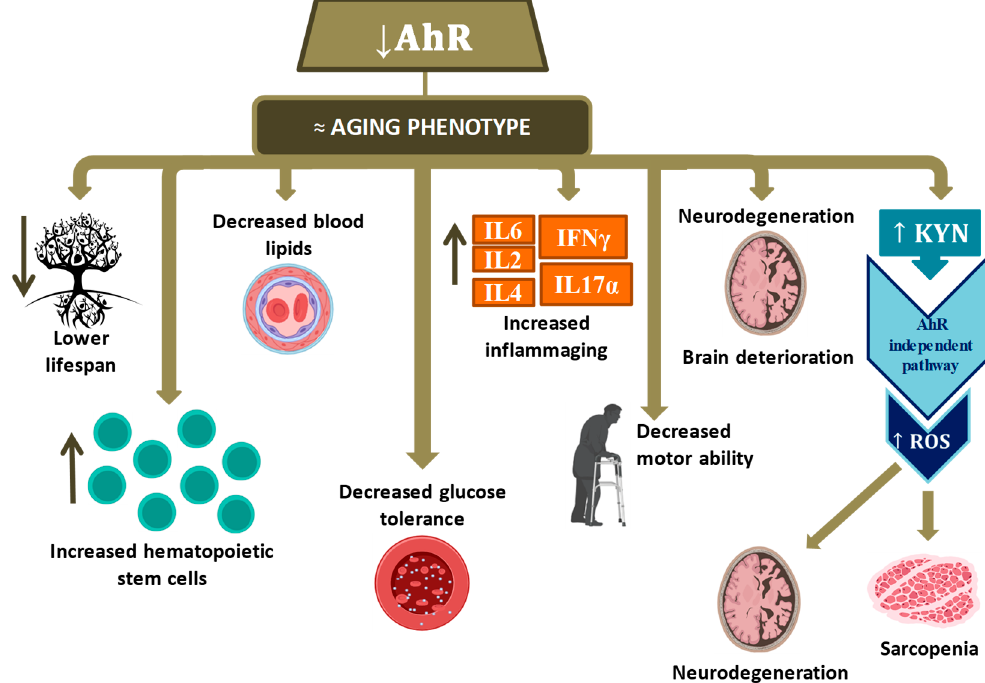
Figure 3. Pathophysiological processes observed when AhR decreases in aging. Hematopoietic stem cells (HSC); Interleukin (IL); Interferon (INF); Kynurenine (KYN); Reactive oxygen species (ROS). Up arrow means it increases and down arrow means it decreases.